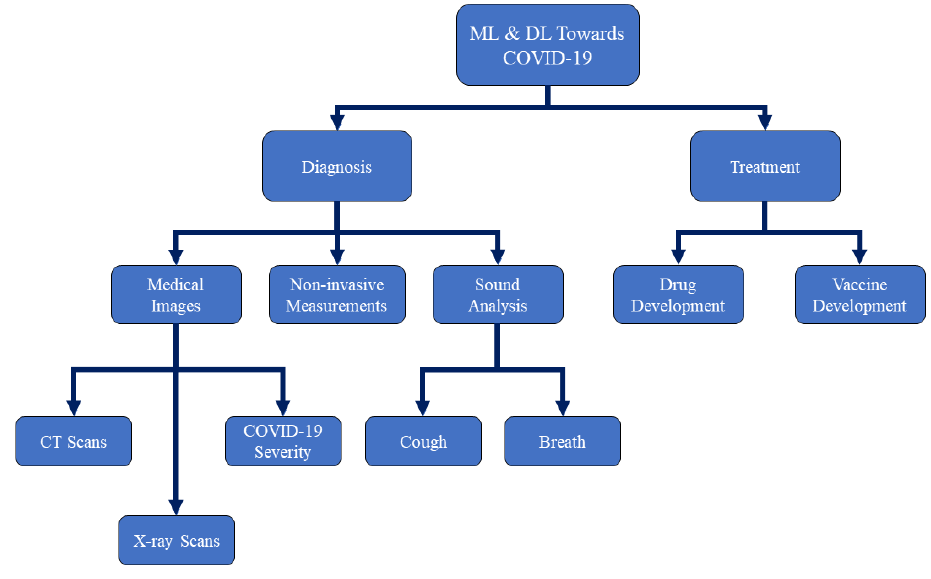
Figure 1. A taxonomy of our survey on Machine Learning (ML) and Deep Learning (DL) research works towards Corona-virus 2019 (COVID-19) diagnosis and